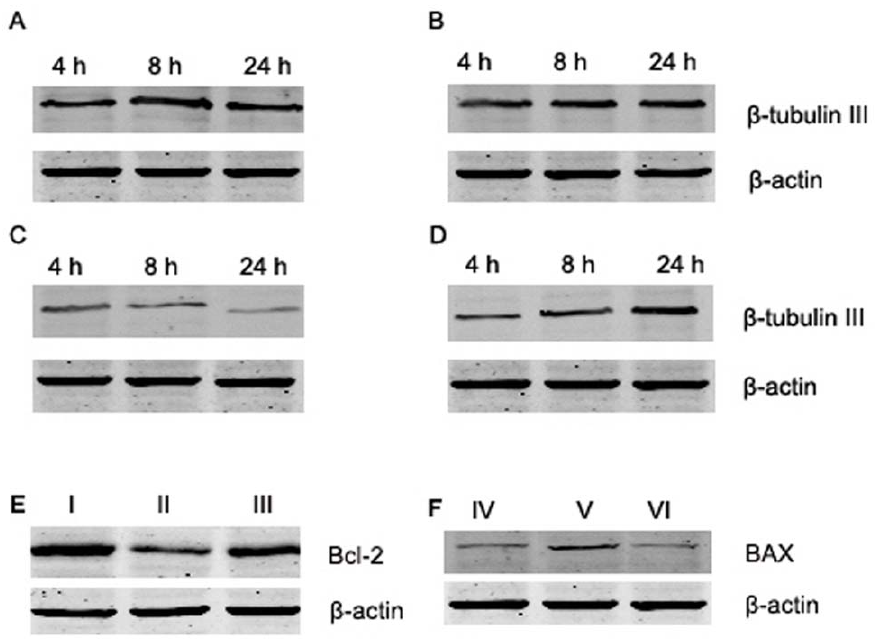
Figure 5. Changes in cytoskeletal and apoptosis-related protein expression in DRG neurons after exposure to mechanical pressure. After cells were subjected to mechanical pressure injury, the expression of b III-tubulin III, Bcl-2, and BAX was determined with western blotting. The expression of b III-tubulinis shown in (A) control cells, (B) control cells treated with PD150606, (C) cells treated with 0.5 MPa of pressure, and (D) cells treated with 0.5 MPa of pressure and PD150606. The expression of Bcl-2 is shown in (E): control cells (I), cells treated with 0.5 MPa of pressure (II), and cells treated with 0.5 MPa of pressure and PD150606 (III). The expression of BAX is shown in (F): control cells (IV), cells treated with 0.5 MPa of pressure (V), and cells treated with 0.5 MPa of pressure and PD150606 (VI). All experiments were repeated at least three